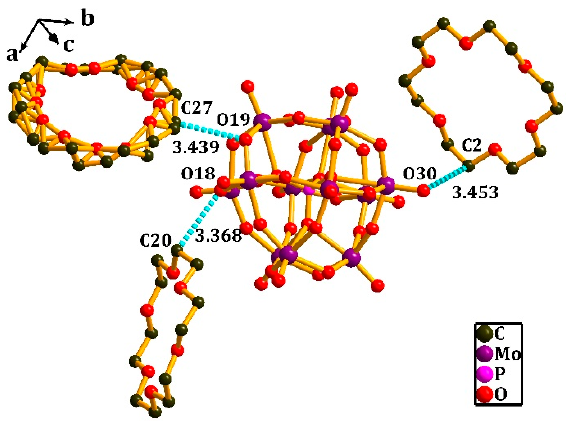
Figure 8. The weak hydrogen bonding interaction between [PMo 12 O 40 ] polyoxoanions and [18]crown-6 molecules. The dotted cyan represents hydrogen-bonding interaction.